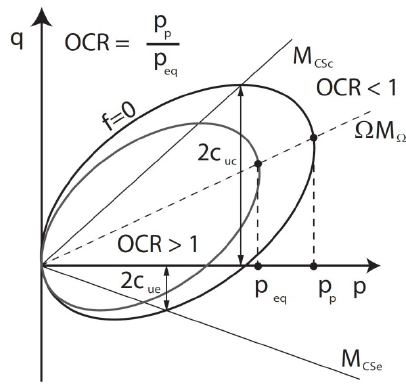
Figure 18: The Niemunis and Grandas-Tavera model [40]. M and M are the slopes of the CSL for triaxial compression and CSe extension, respectively. M denotes the slope of the CSL by the Ω current Ω